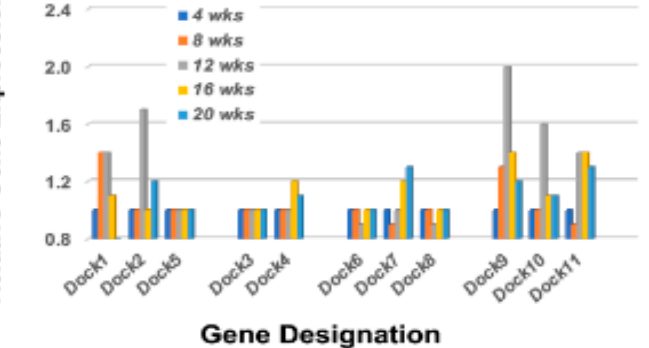
Figure 7. Temporal gene expressions for the Rho-GTP Arhgap and Arhgef gene family members up- regulated in the lacrimal glands of C57BL/6.NOD- Aec1Aec2 mice during onset of SS. Transcriptome data indicating the temporal expressions of the 8 of 23 Arhgap genes (left), and 8 of 17 Arhgef genes (right) found to be upregulated in the lacrimal glands.